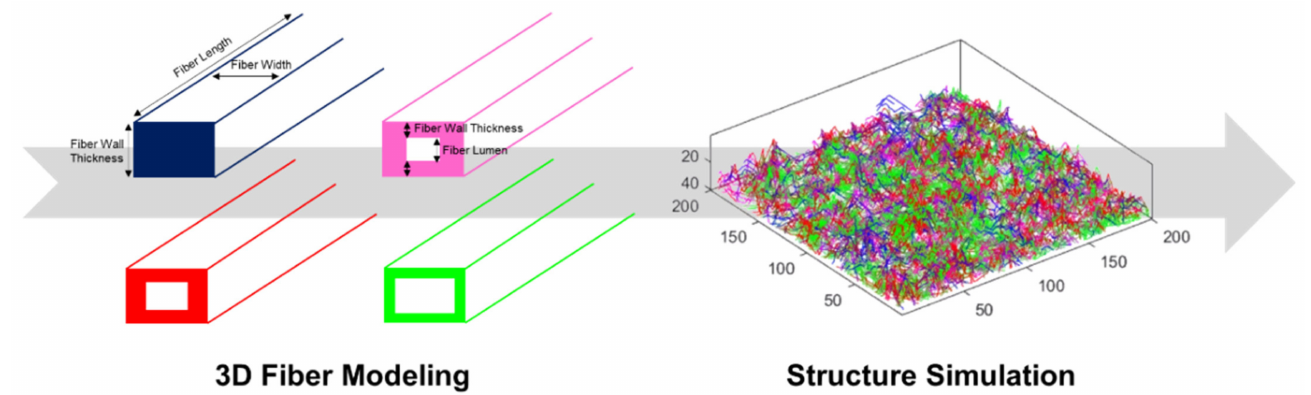
Figure 2. Representative scheme of 3D modeling and computational simulation approach, in which different fibers are represented with different colors. The fibers are modeled according to their dimensions and properties, considering the three fiber dimensions. Modeling is detailed to the point where fiber wall thickness, fiber lumen, flexibility, and degree of collapse are considered. The models consist of fibers without lumen and with different lumen dimensions [46]. Finally, 3D structures are simulated from these proposed models in order to predict structural properties and, consequently, optimize functional properties.